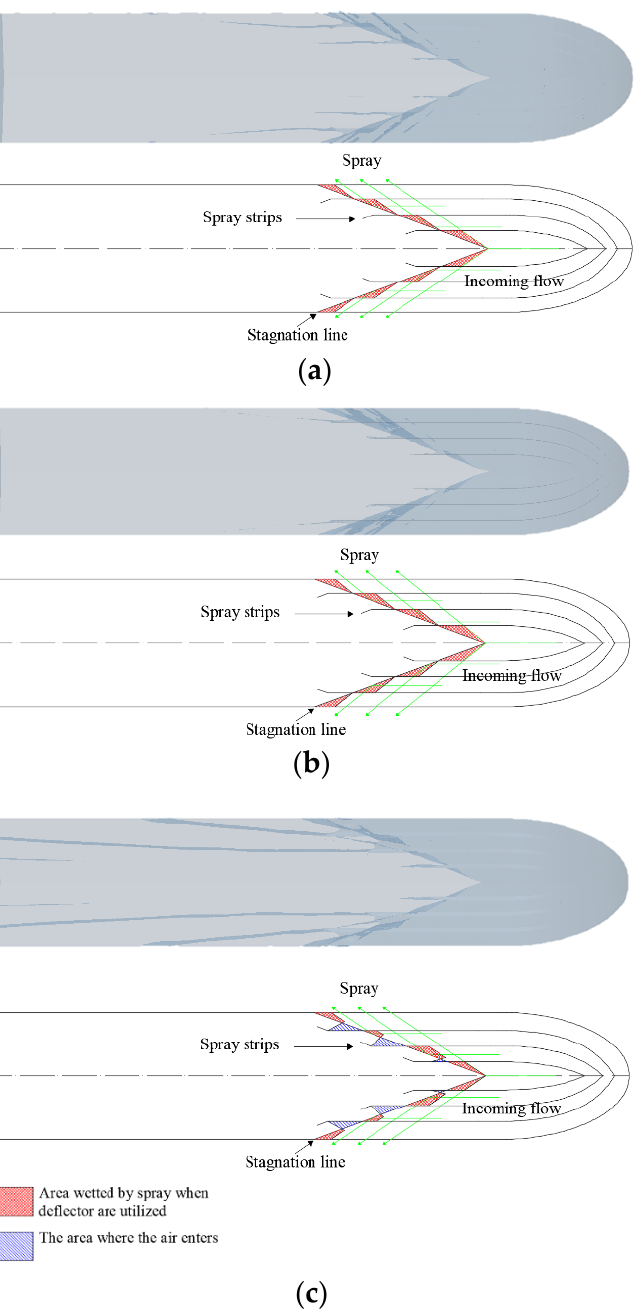
Figure 12. Comparison of spray area due to deflection by spray strip at Fr 1.78 for ( a ) conventional profile; ( b ) Savitsky profile; ( c ) suggestion profile.